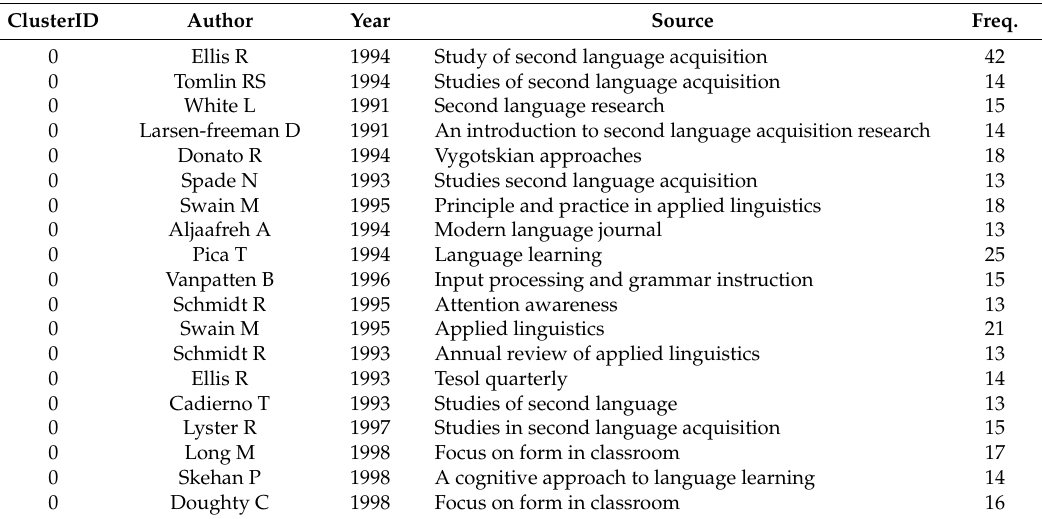
Table 2. The members of Cluster